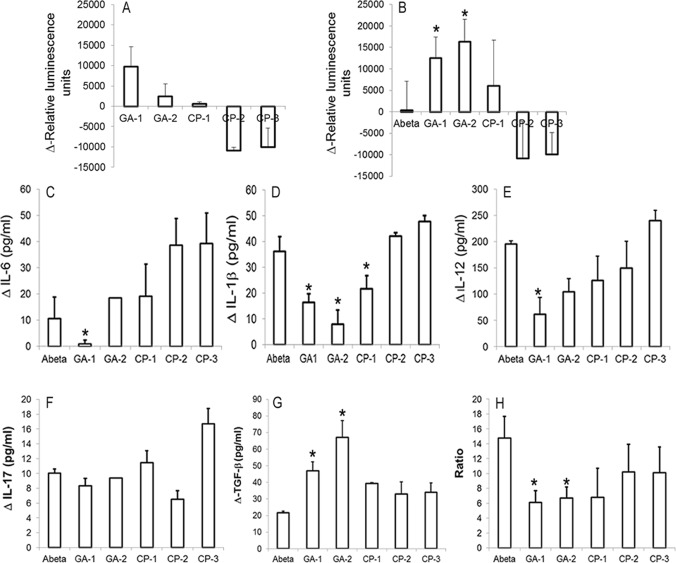
Effect of GILZ analog (GA) treatment on human fetal brain cells (HFB): (A,B): Select GA decrease metabolic activity in Aβ1–42 exposed HFB. Primary cultures of HFB (Div 17) were exposed to Aβ1–42 and treated with 50M of indicated GA or control peptide (CP). Cytoplasmic extracts of cells collected at 24h was assessed for viability by CTG assay. Data are presented as ΔRLU (difference in relative luminescent units (RLU) between the Aβ1–42 exposed cells and unexposed cells) (A, B). GA suppresses inflammatory cytokines in activated HFB. HFB cells were cultured as above and culture medium collected at 24hrs was assessed for pro-inflammatory (IL-1β, IL-6 and IL-17) (C, D, E and F) and anti-inflammatory (TGF-β) (G) cytokines. (H) Effect of GA on NF-κΒ activation. Primary cultures of HFB exposed to Aβ1–42 (10μg/ml) and treated with indicated GA or CP as above were harvested at the end of 4 h. 5μg of nuclear extract was tested for binding of the activated p65 NF-κΒ subunit to an NF-κΒ consensus sequence using the Trans AM NF-κΒ ELISA kit. The p65 DNA binding activity was calculated as the ratio of absorbance from Aβ1–42 stimulated cells to that of unstimulated cells. Values are the average/-S.D from two experiments. * = p<0.05 as compared to Aβ1–42 exposed cells, @ = p<0.05 as compared with Aβ1–42 and CP-1 or CP-2 treated cultures.